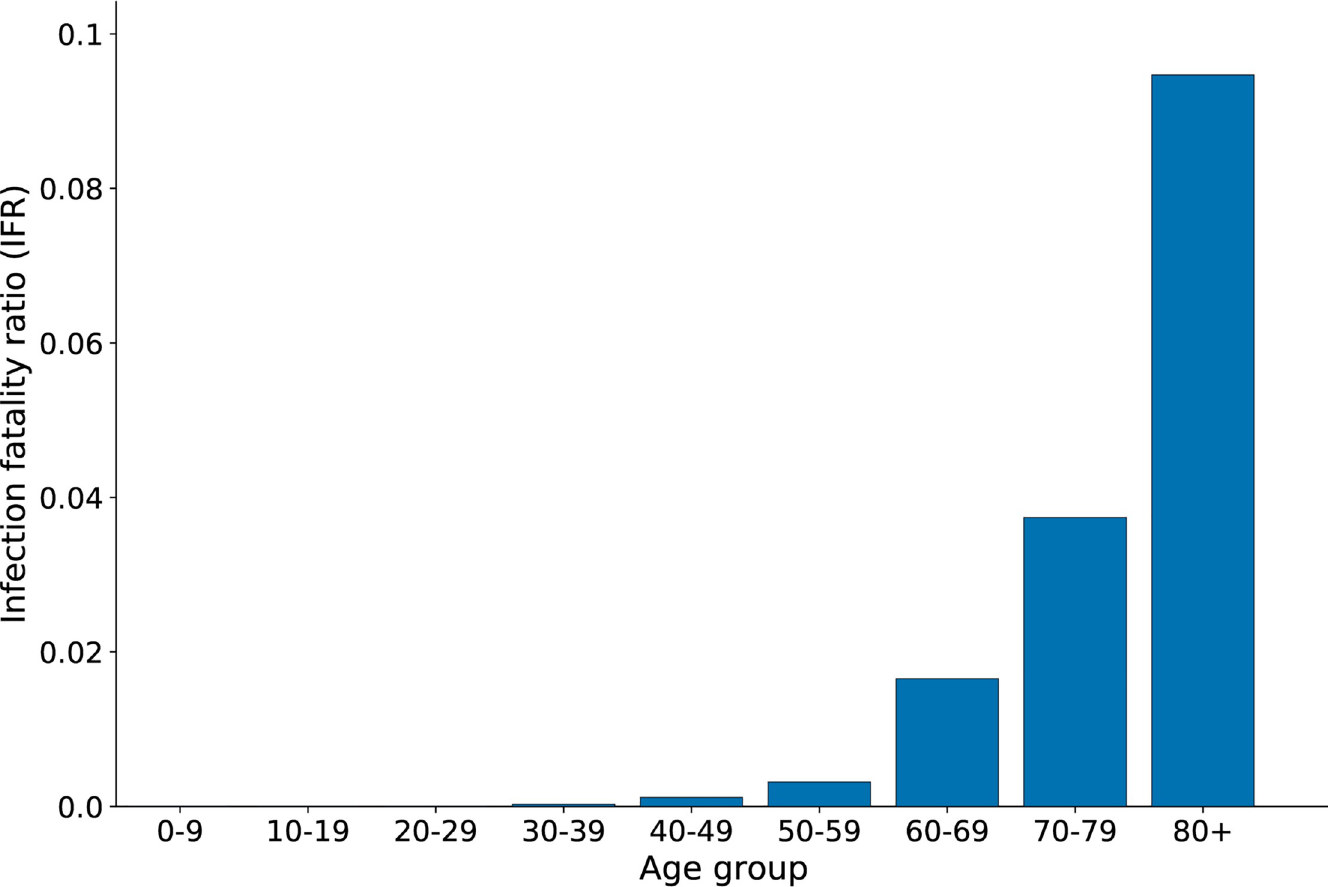
Fig 4. Age-stratified infection fatality ratio (IFR) from a single simulation of OpenABM-Covid19. Simulation in a population of 1 million with UK-like demography and with a lockdown when SARS-CoV2 prevalence reached 1.55%.